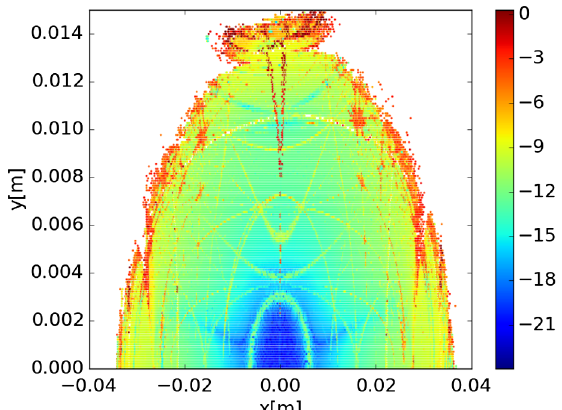
FIG. 8. Dynamic aperture for on-momentum particles. The color represents the tune diffusion obtained by turn-by-turn tracking simulation. Diffusion [37] is defined as the difference of tunes Δ ν extracted from the different time durations ffiffiffiffiffiffiffiffiffiffiffiffiffiffiffiffiffiffiffiffiffiffi q Δ ν 2 þ Δ ν 2 Diff ¼ log 10 . A cool color means the motion is ¼ 0 mrad is x y y less chaotic and vice